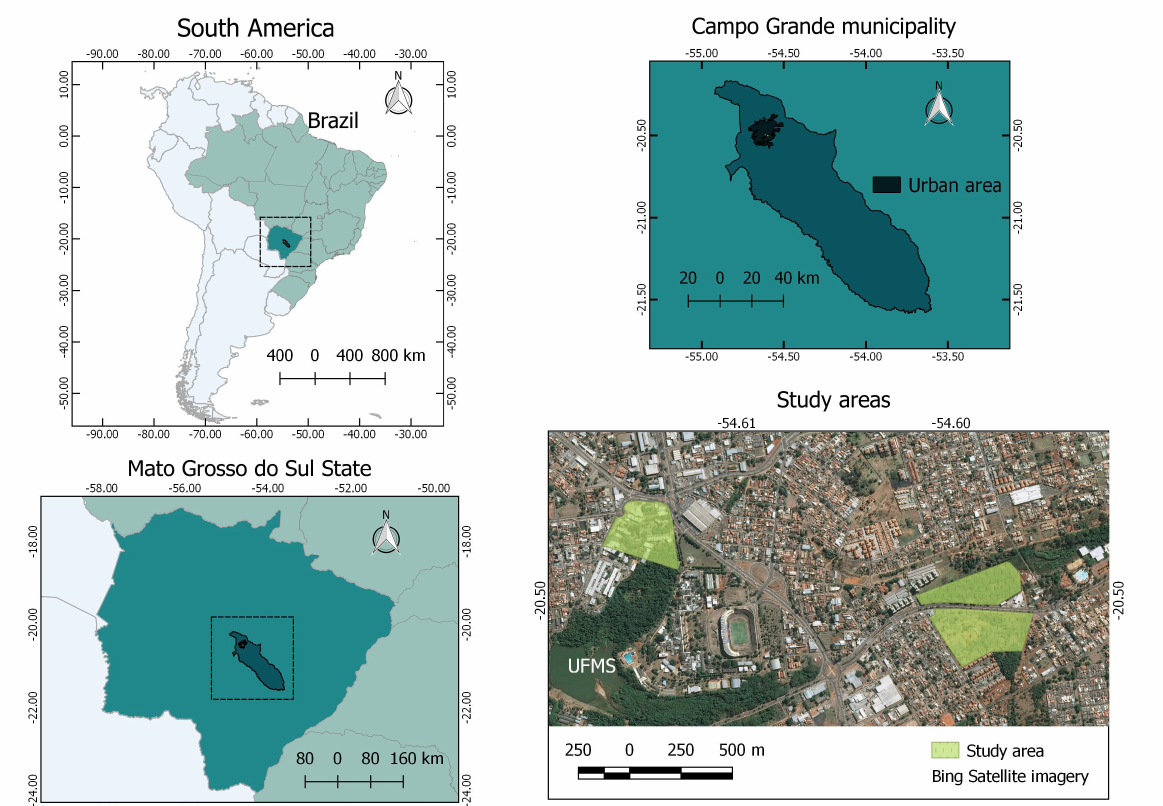
Figure 1. Study area at Campo Grande, Mato Grosso do Sul,